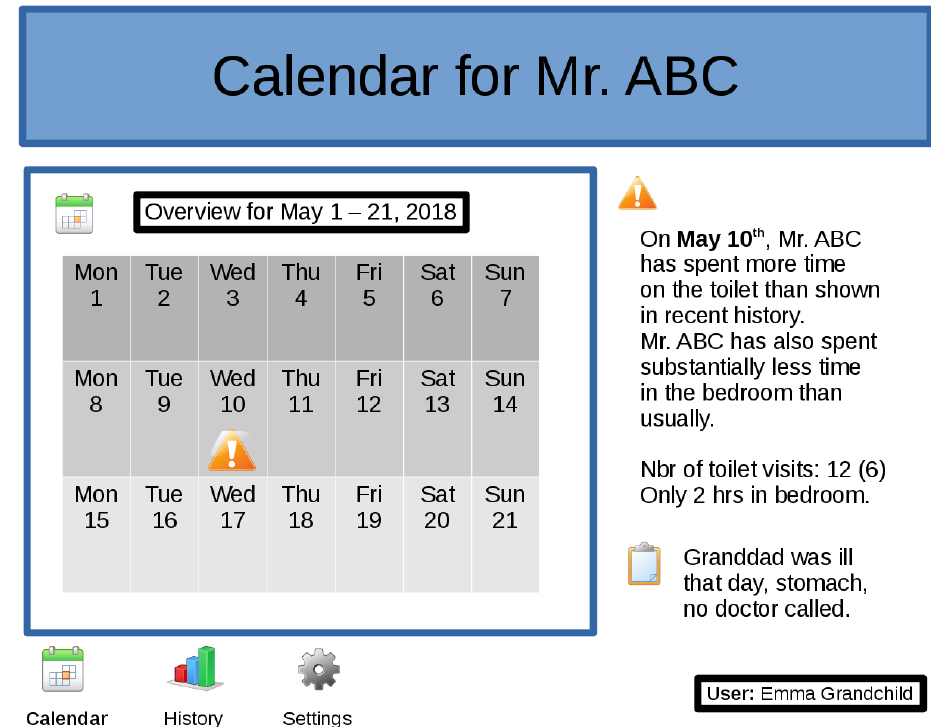
Figure 5. Example of a dashboard with a possible relevant event. The calendar gives an overview while some possible causes are given on the right side, together with the possibility to add a quick